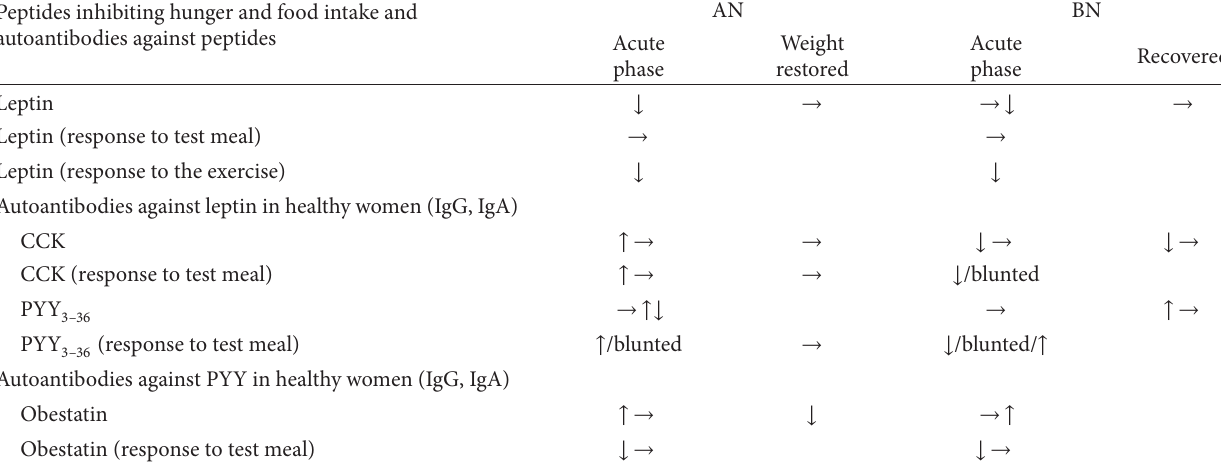
↑ : higher than healthy controls, ↓ : lower than healthy controls, and → : not different from healthy